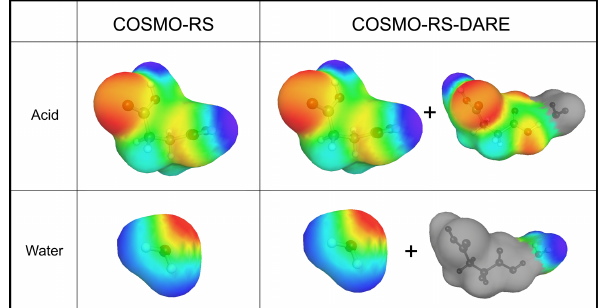
Figure 1. The σ surfaces of succinic acid and water conform- ers used in COSMO-RS and COSMO-RS-DARE calculations. The conformer distributions in COSMO-RS-DARE include parts of cluster σ surfaces (in this example a hydrate cluster). Color cod- ing of σ surfaces: red is negative partial charge, blue is positive partial charge, green is neutral partial charge, and grey is omitted σ